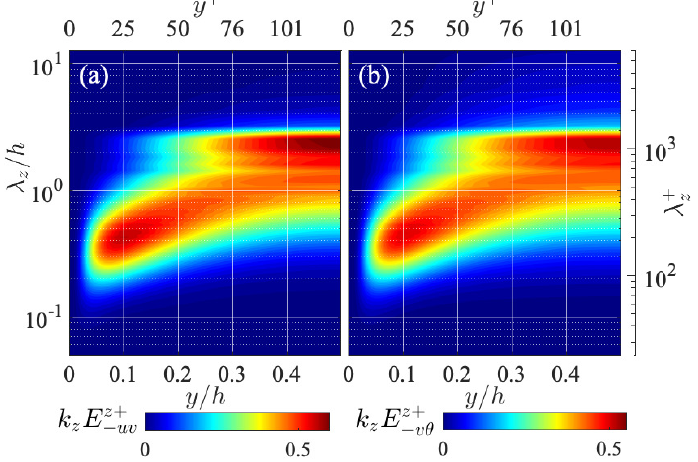
Figure 4. Spanwise one-dimensional spectra of ( a ) the Reynolds shear stress E z − uv and ( b ) turbulent heat transfer E z − , presented in the same manner as in Figure v θ